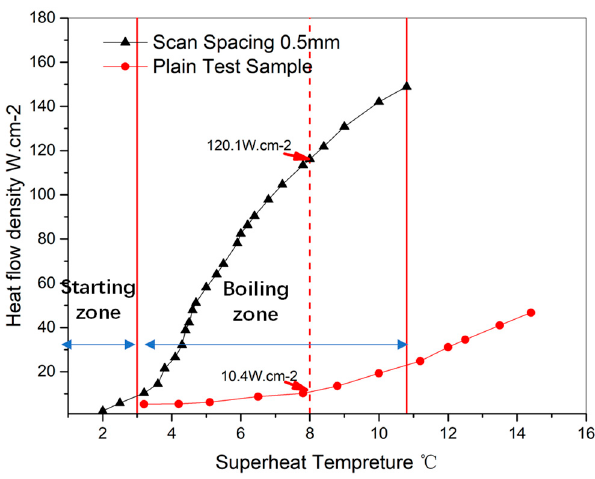
Figure 13. Saturated boiling curves corresponding to the grid structure and plain test sample.